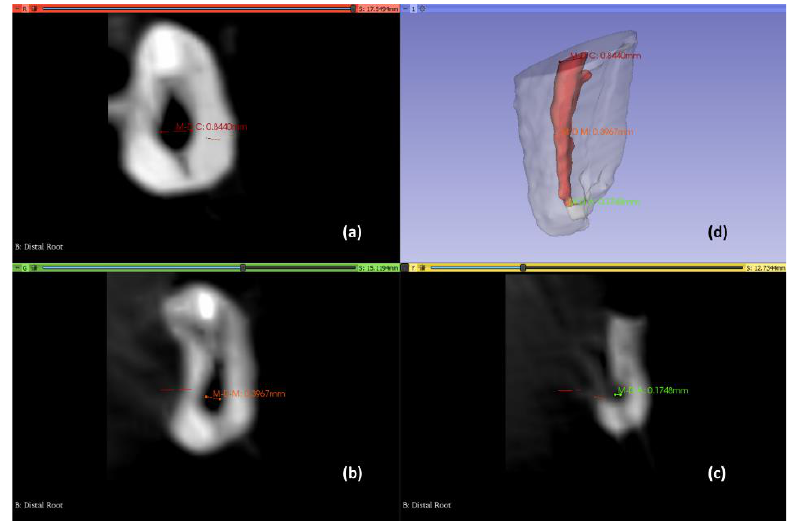
Figure 5. Axial views to determine the root canal diameter and three-dimensional reconstruction. Coronal third ( a ); Middle third ( b ); Apical third ( c ); three-dimensional reconstruction view ( d ).